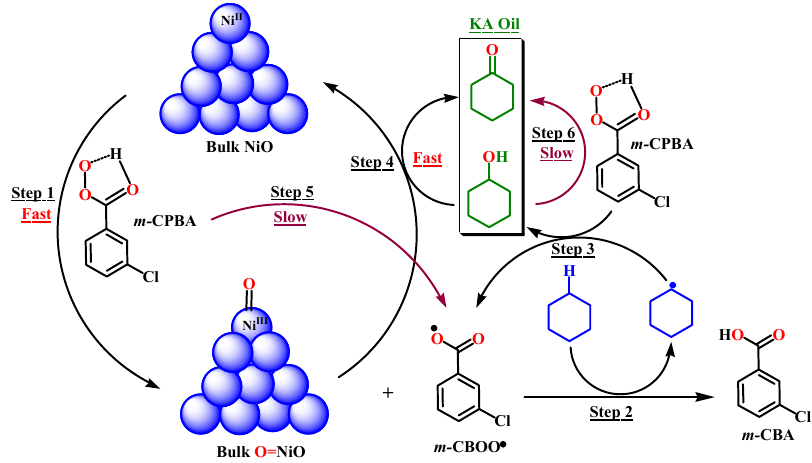
Figure 12. Possible mechanism for the oxidation of cyclohexane over bulk NiO.